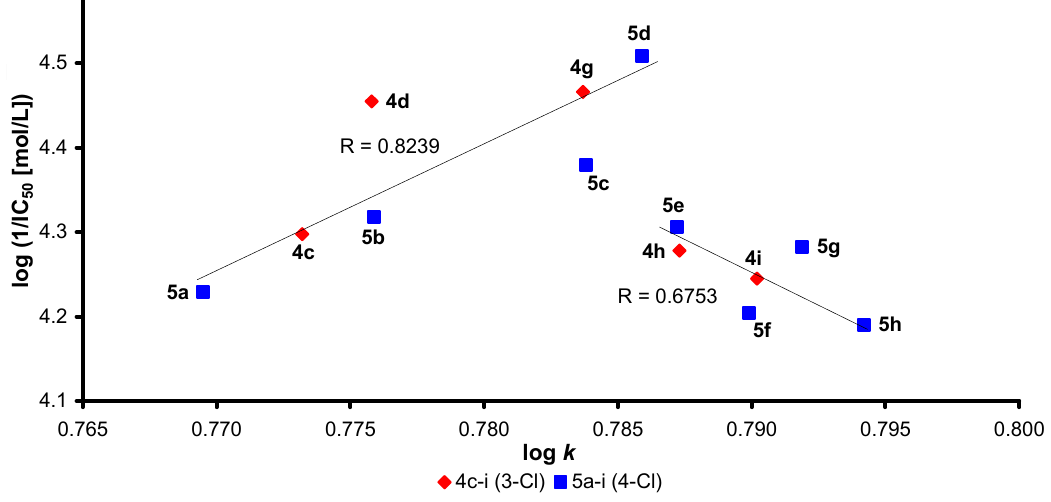
[mol/L]) on lipophilicity of 50